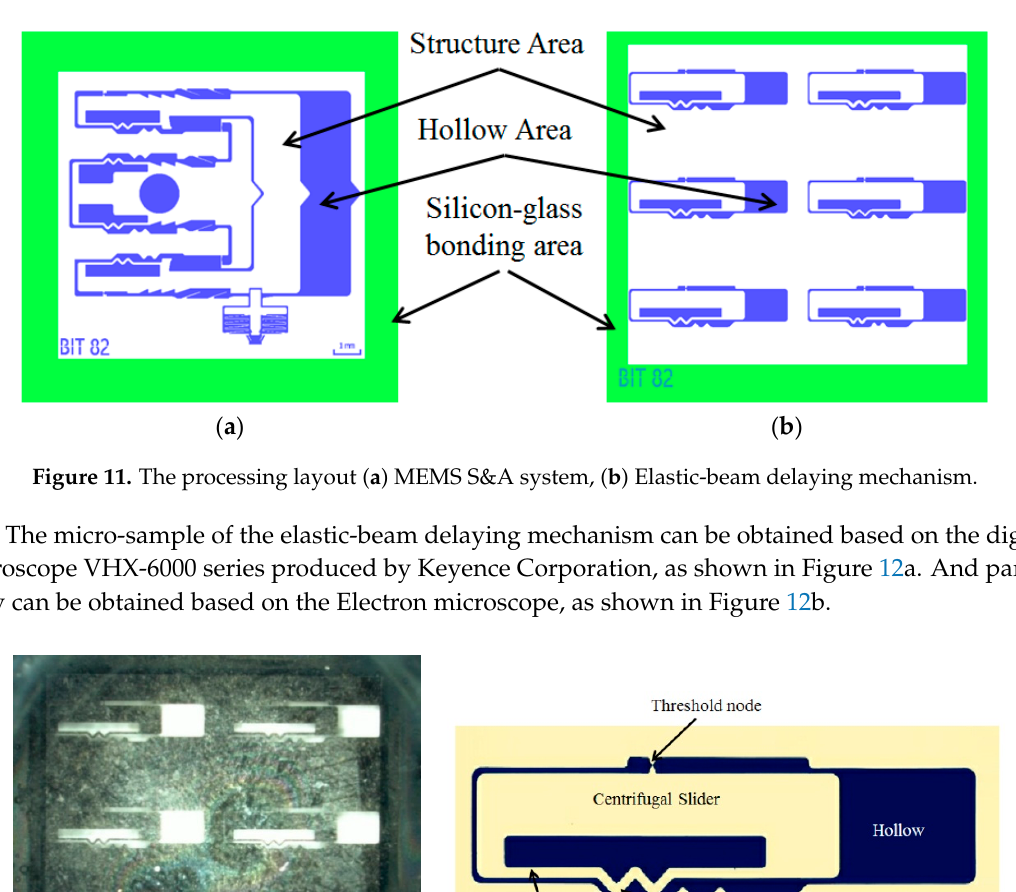
Figure 10. Micromachining process of silicon-based MEMS S&A system ( a ) Back-up; ( b ) Physical Vapor Deposition (PVD) Al 2um; ( c ) PVD Al 0.2um; ( d ) Structural lithography; ( e ) Corroded aluminum; ( f ) Deep Reactive Ion Etching (DRIE); ( g ) Degumming; ( h ) Back-up; ( i ) BCB Lithography;